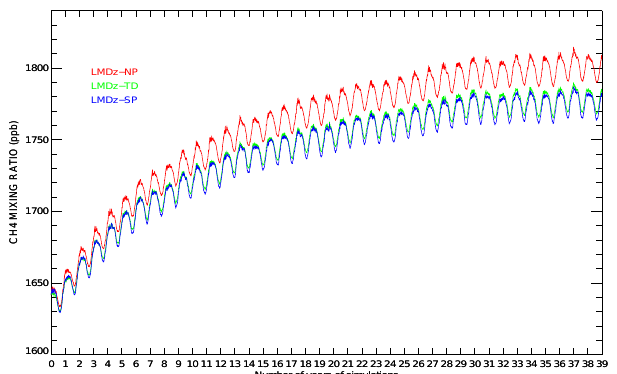
Figure 10. Time series of global-mean CH 4 dry mole fraction av- eraged between the surface and 850hPa, for NP (red), SP (blue) and TD (green) for 39 years of simulation. Identical initial value (1650ppb for CH 4 at the surface) and constant flux (500Tg of CH 4 per year) are used in these